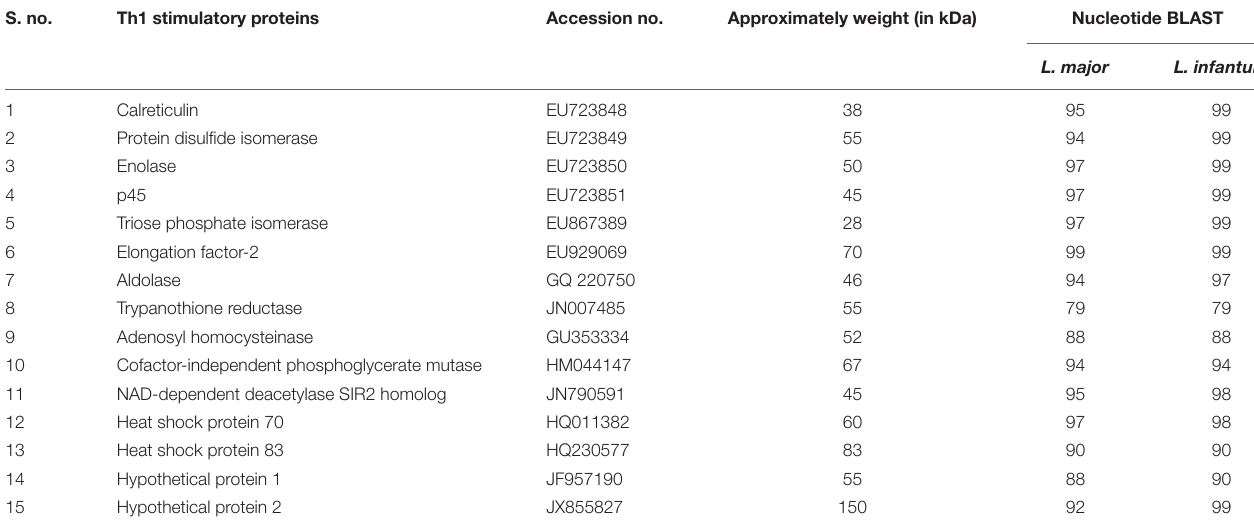
TABLE 1 | List of recombinant proteins with their accession no. submitted to the national center for biotechnology information (NCBI). S. no.